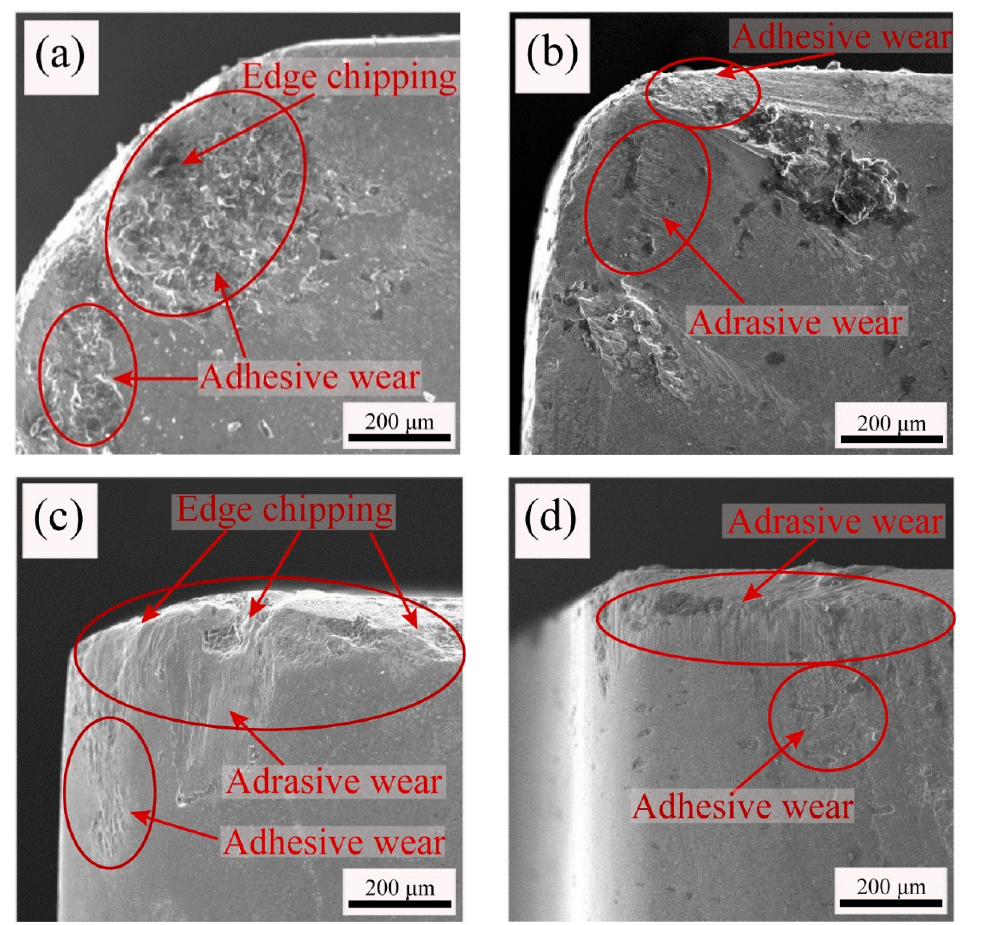
Figure 12. The wear morphology of the ATS and ATSC10 ceramic tools: ( a ) front surfaces of the ATS, ( b ) front surfaces of the ATSC10, ( c ) back face of the ATS, ( d ) back face of the ATSC10.